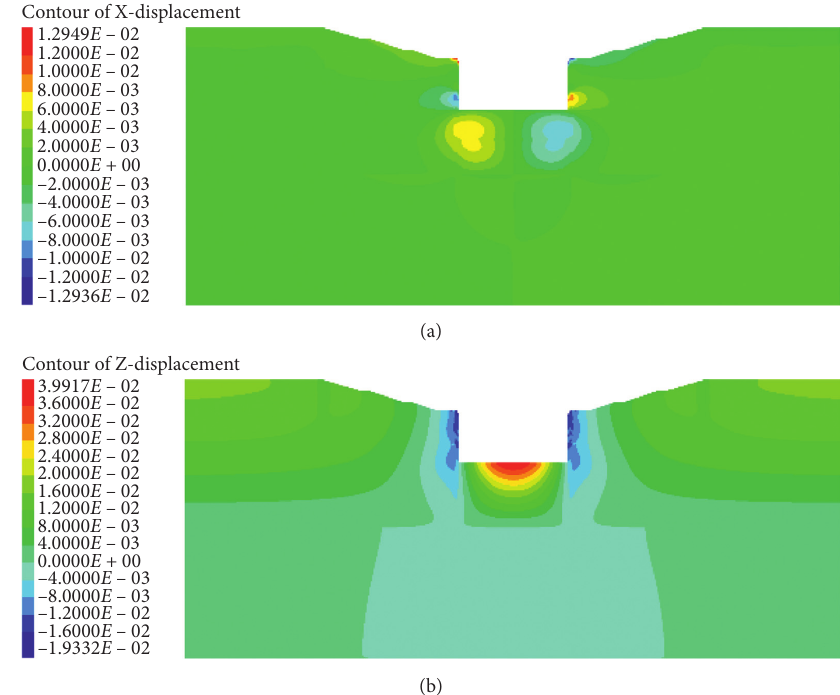
Figure 8: Contour of displacement in the NW area. (a) Contour of X -displacement. (b) Contour of Z -displacement.